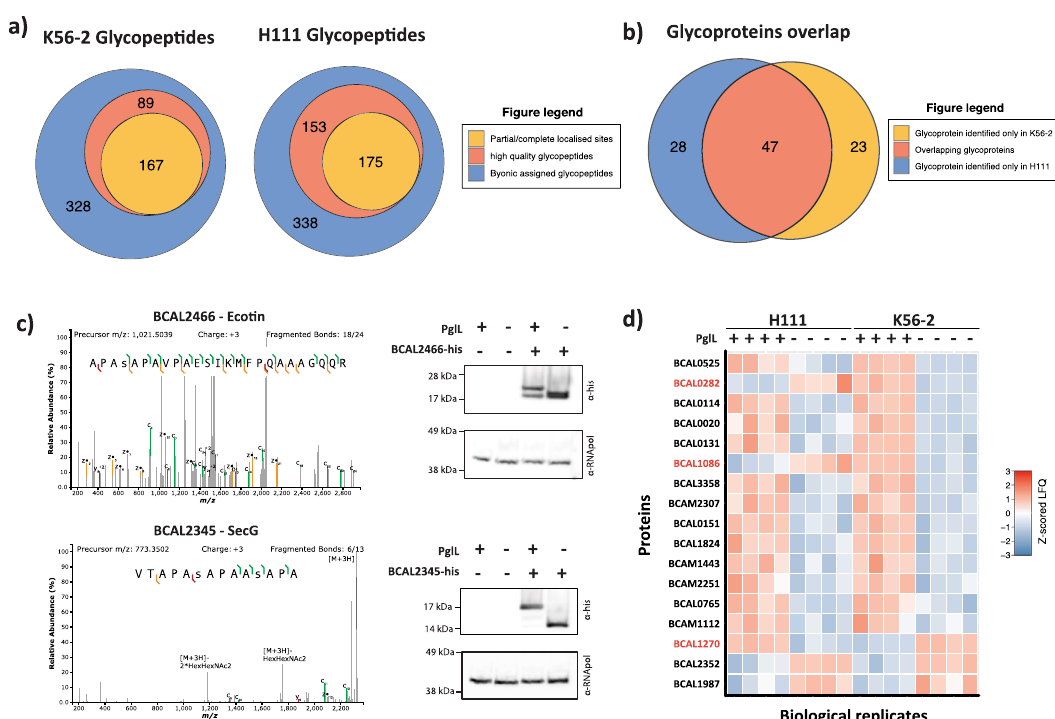
Fig. 1 B. cenocepacia glycoproteomic analysis reveals similar substrates and functional impacts on B. cenocepacia strains. a Within B. cenocepacia strains K56-2 and H111 584 and 666 unique glycopeptides were identi fi ed respectively (Byonic scores >300). Within these glycopeptides manual curation identi fi ed 256 and 328 glycopeptides as high-quality unique glycopeptides of which 167 and 175 provided partial or complete glycosylation site information. b Across the manually curated glycopeptides a total of 98 unique glycoproteins were identi fi ed of which 47 were identi fi ed within both strains. c Western blotting of two potential glycoproteins, His 6 tagged BCAL2466 and BCAL2345, reveals alterations in protein banding when expressed within the glycosylation null strain K56-2 Δ pglL compared to K56-2 WT with anti-RNA pol westerns included as loading controls. d LFQ analysis of the most altered proteins observed between H111 Δ pglL compared to H111 WT reveals similar proteome alterations as seen previously within K56-2 5